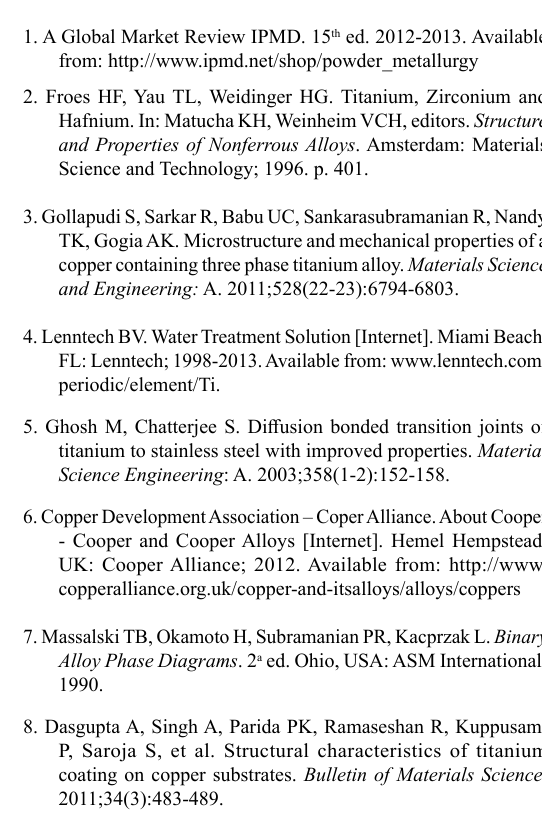
Figure 6. Definitions of some commonly used roughness parameters 22